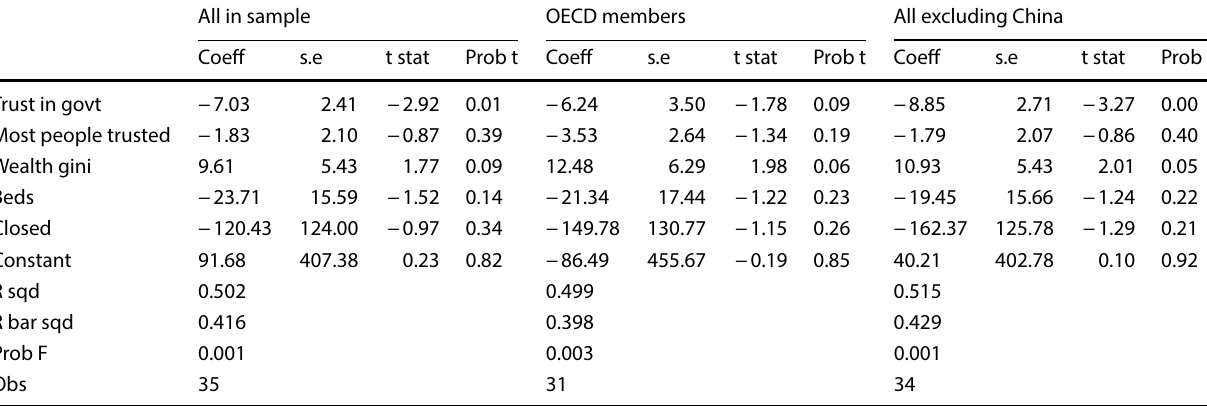
Table 11 Regression results for the first period including “closed” as a variable